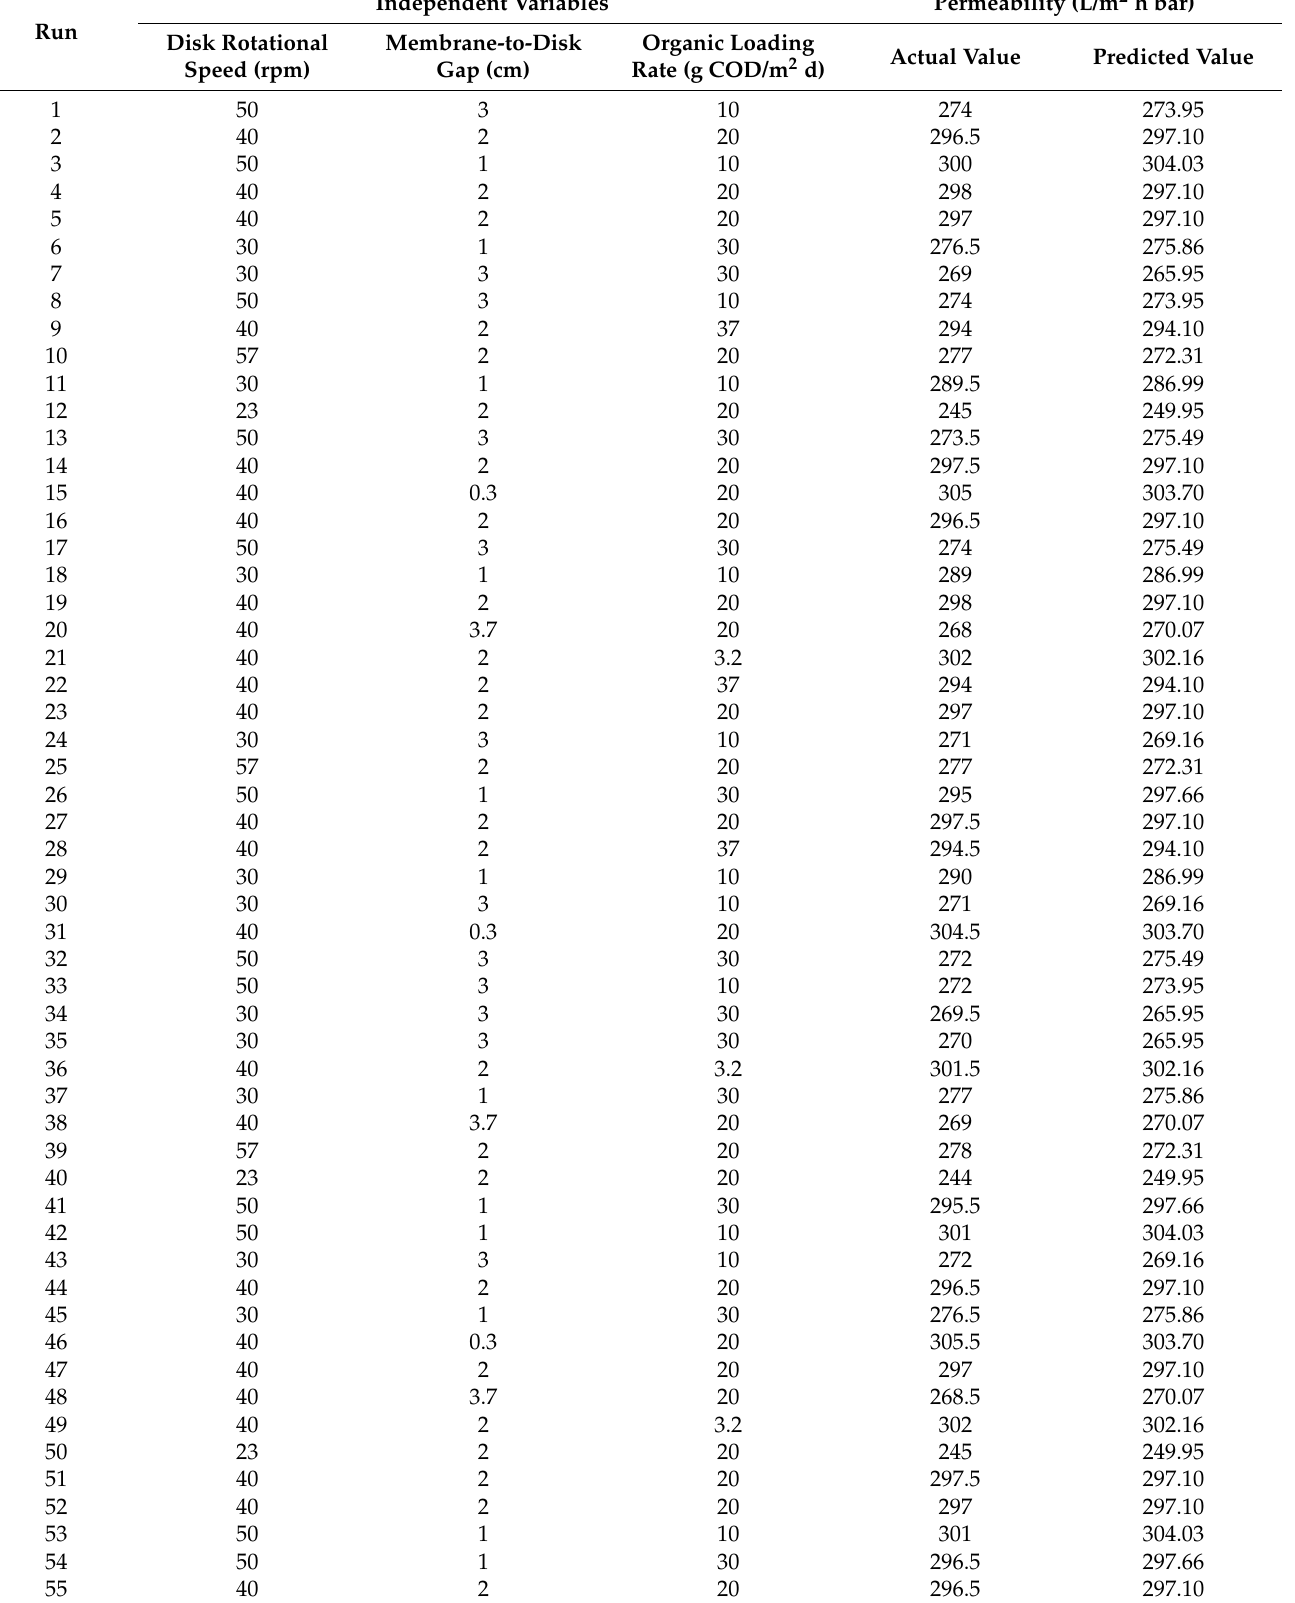
Table 3. Design of experimental runs for the independent variables and response